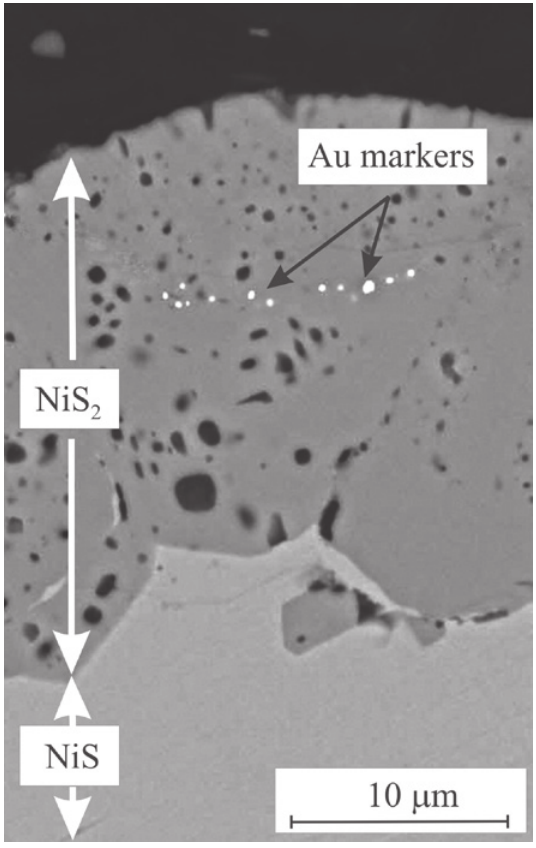
Fig. 4: BSE microphotograph of metallographic cross-section of NiS 2 layer, formed on NiS surface during sulphidation of NiS “marked” by gold islands.